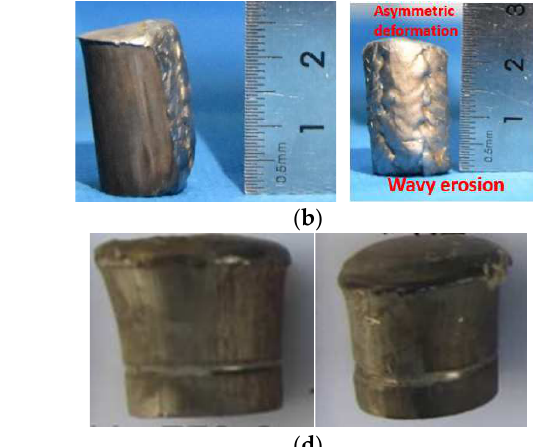
（ ） Z-displacement cm Figure 11. Trajectory of projectile in Test 3. (The red dash line is the dividing line of different stages) 3.2. Analysis of Residual Characteristics of Projectile Penetrating into Liquid Cabin at an Attack Angle Figure 12 shows the deformation and failure morphology of the projectiles after the penetration tests under various attack angles. Mass abrasion occurs in both radial and axial directions of the projectile (the residual mass increases due to high-temperature fu-